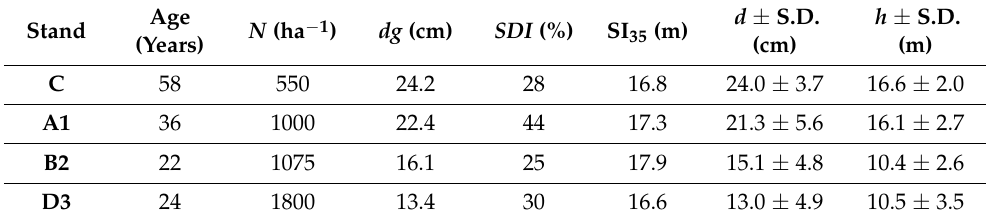
Table 2. Stand information: age (years), stand density ( N , ha − 1 ), quadratic mean diameter ( dg , cm), stand density index ( SDI , %), site index (SI 35 , m), mean tree diameter ( d , cm) ± standard deviation (S.D.), and mean tree height ( h , m) ±